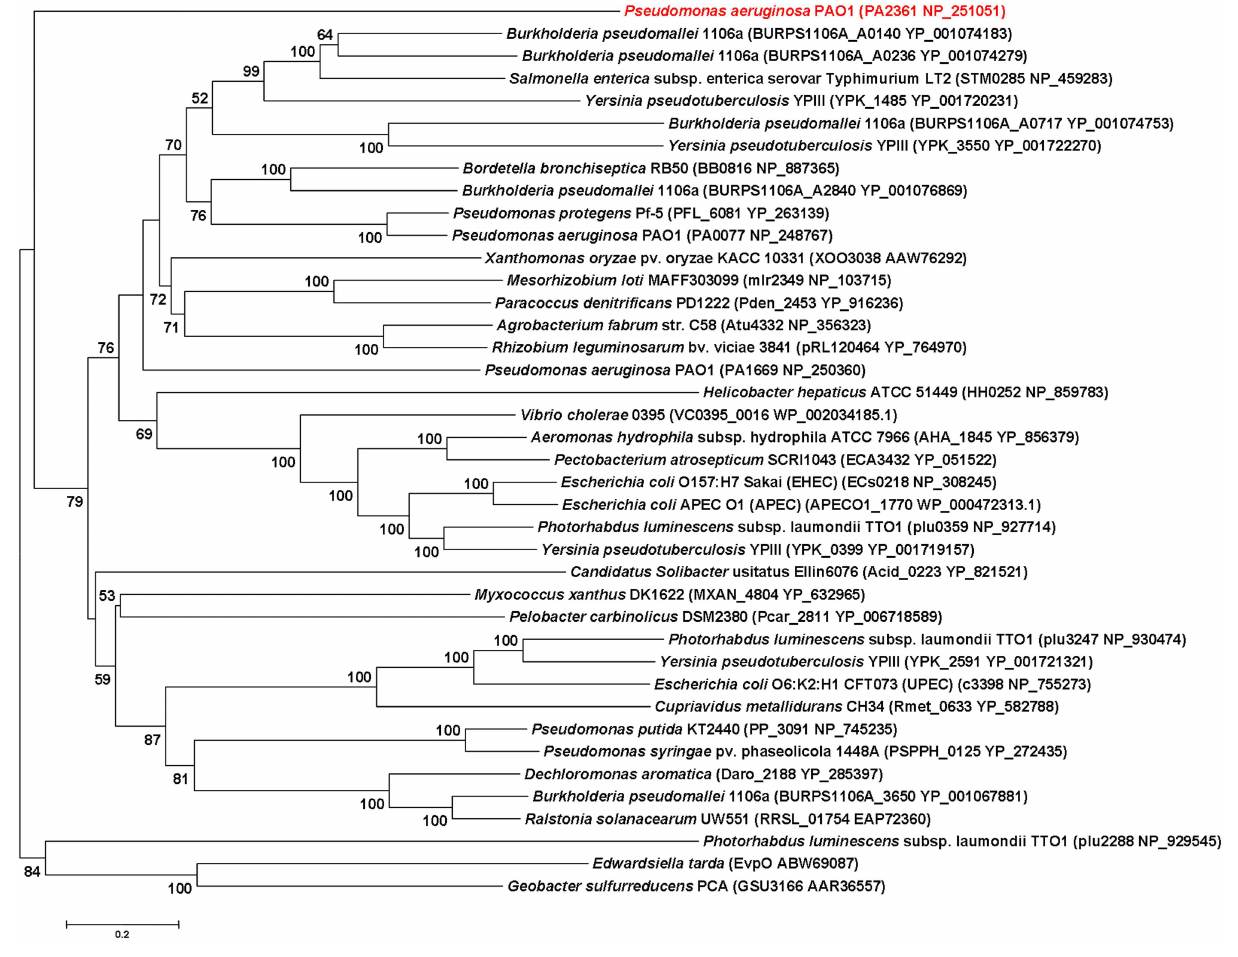
Frontiers in Cellular and Infection Microbiology |